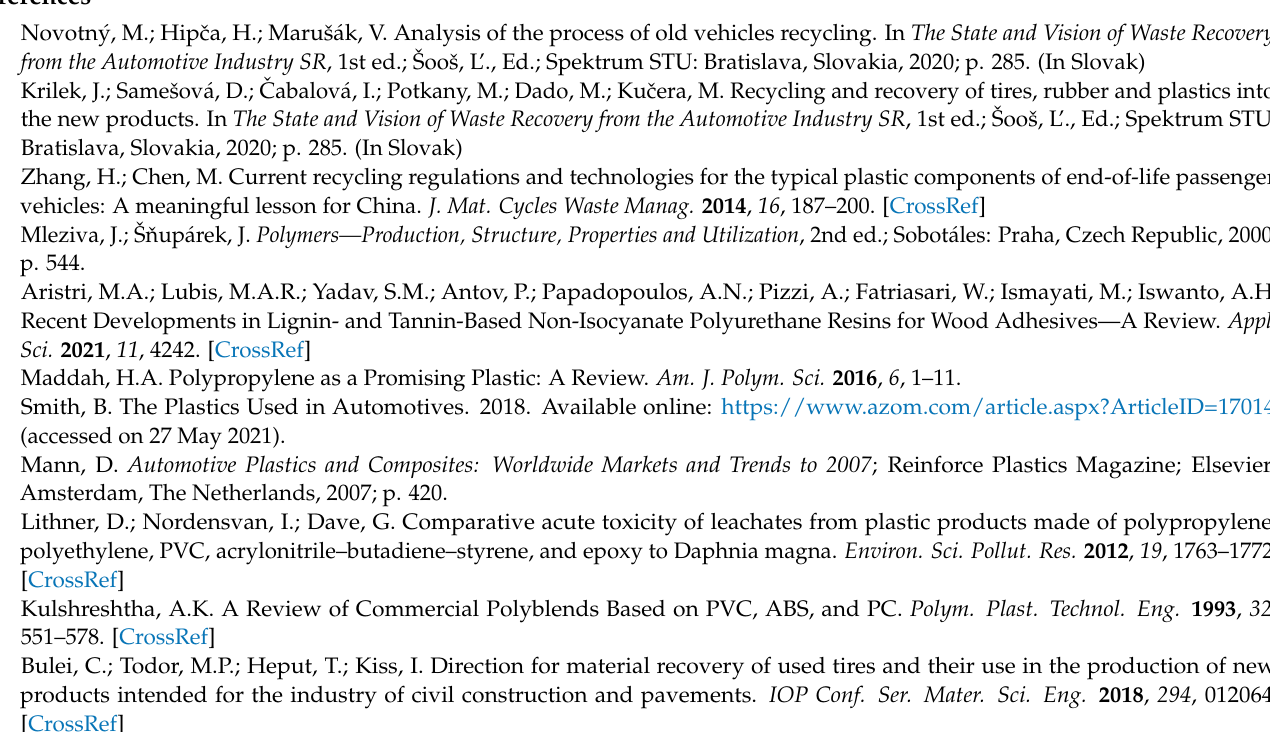
Table S2: Identified substances after pyrolysis (500 ◦ C) of sample 2, Table S3: Identified substances after pyrolysis (500 ◦ C) of sample 3, Table S4: Identified substances after pyrolysis (500 ◦ C) of sample 4, Table S5: Identified substances after pyrolysis (500 ◦ C) of sample 5, Table S6: Identified substances after pyrolysis (500 ◦ C) of sample 6, Table S7: Identified substances after pyrolysis (500 ◦ C) of sample 7, Table S8: Identified substances after pyrolysis (500 ◦ C) of sample 8, Table S9: Identified substances after pyrolysis (500 ◦ C) of sample 9, Table S10: Identified substances after pyrolysis (500 ◦ C) of sample 10, Table S11: Identified substances after pyrolysis (500 ◦ C) of sample 11, Table S12: Identified substances after pyrolysis (500 ◦ C) of sample